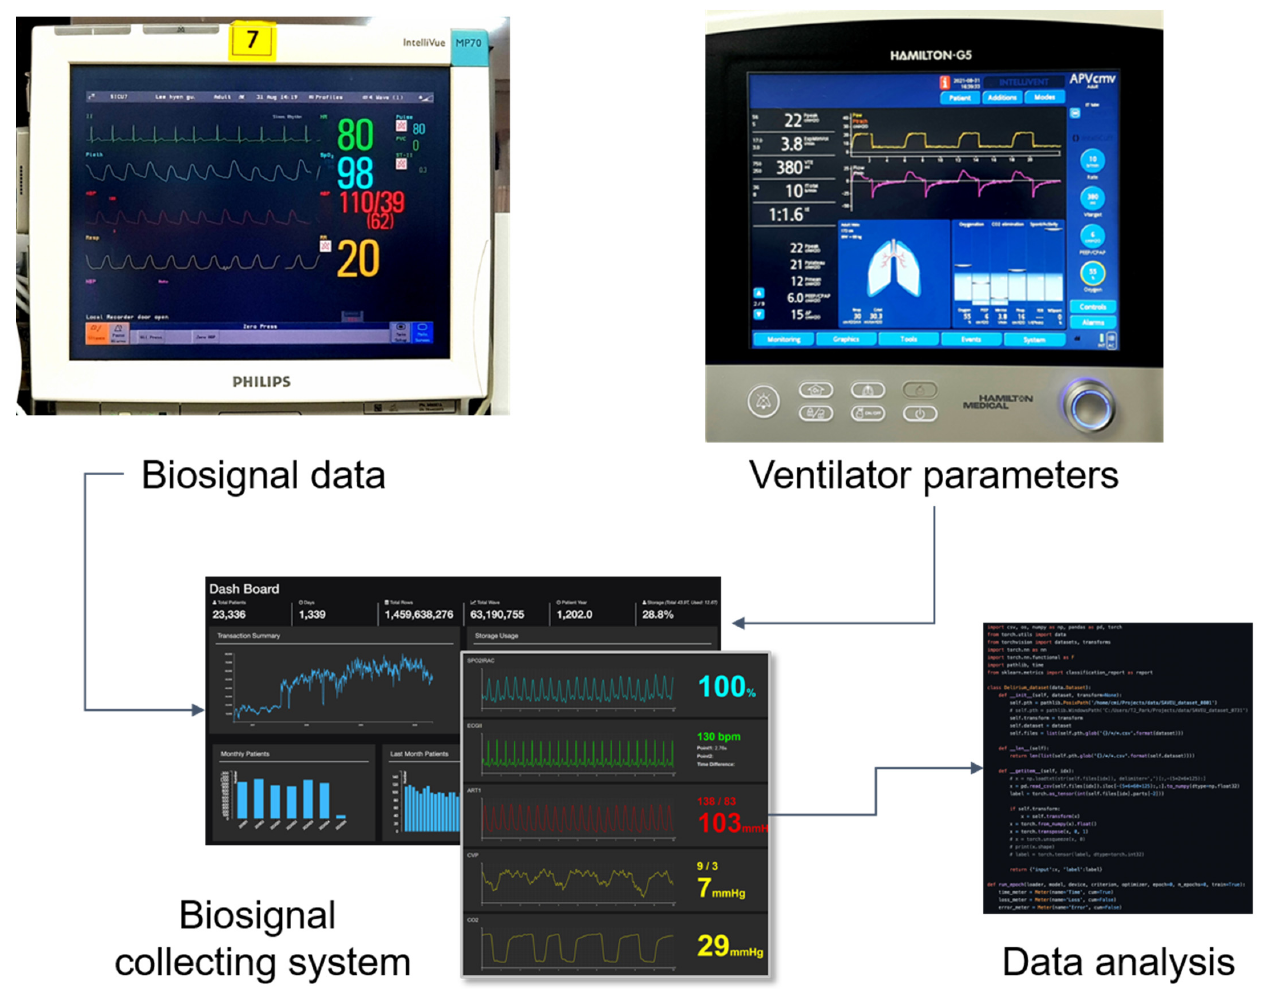
Figure 1. Biosignal data collecting and data analysis process. Biosignal data from patient monitor devices and parameters from mechanical ventilators were collected via our biosignal collecting system. Collected data were analyzed retrospectively to find out features for predicting weaning success.